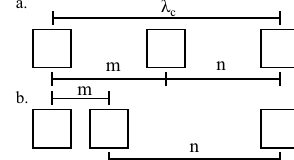
meander structures were utilised in the experiments. Two of the samples have (cid:31) g = 4 mm, W = 1 mm with (1) L m = 10 mm and (2) L m = 5 mm. The third sample (3) has (cid:31) g = 6 mm, W = 2 mm with L m = 5 mm. These samples are covered with acoustically rigid tape so that a central hole of 1 mm is left exposed along the structure. For sample (2) the position of the hole in y along the straight section is also varied. The dispersion of the surface waves supported by these structures are measured using the technique discussed in the “Methods” section.